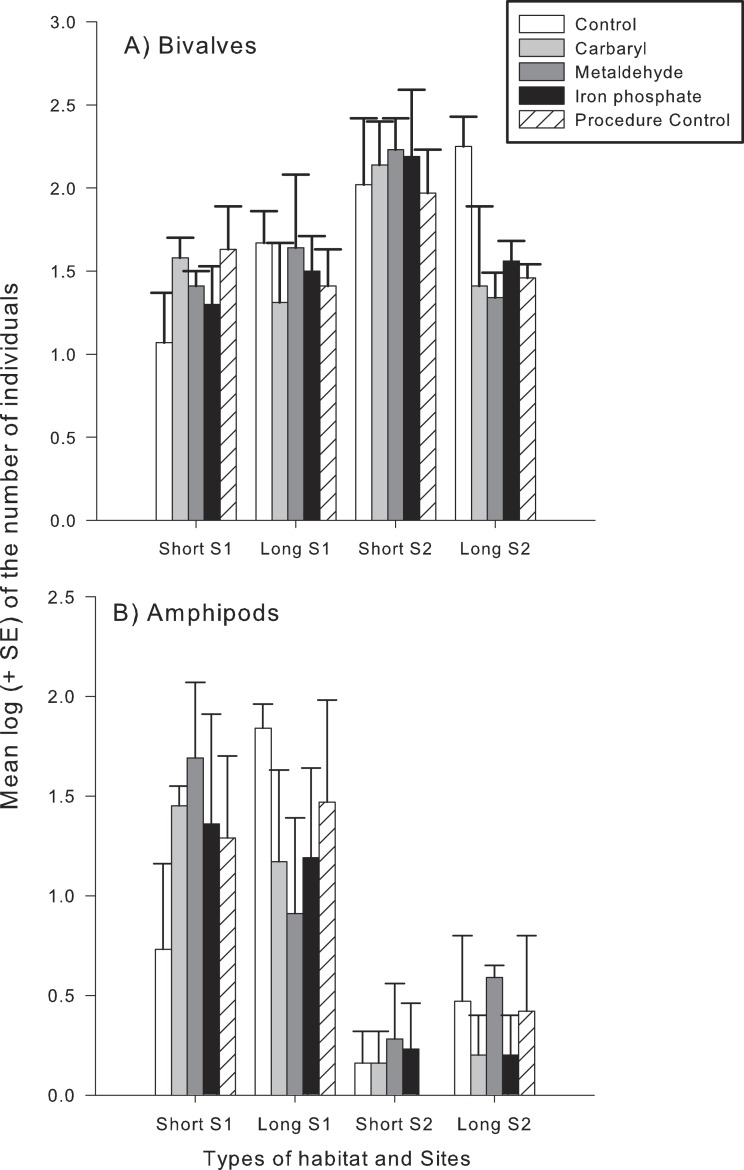
Mean log (+SE) of the number of individuals of (A), bivalves (B) and amphipods in each type of experimental habitat and each contaminant treatment.Bars with different colours indicate different treatments: controls (white), Carbaryl (light-gray), Metaldehyde (dark-gray), Iron (black) and Procedural controls (striped).